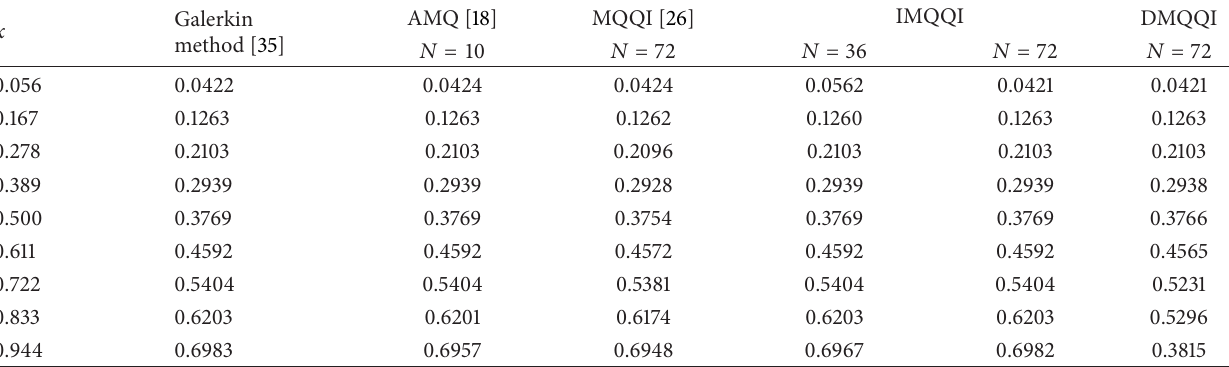
Table 3: Comparison of results with the results of [18, 26, 35] for 𝜐 = 0.0001 and Δ𝑡 = 0.001 at 𝑡 = 1 for different values of 𝑥 of Experiment 1.